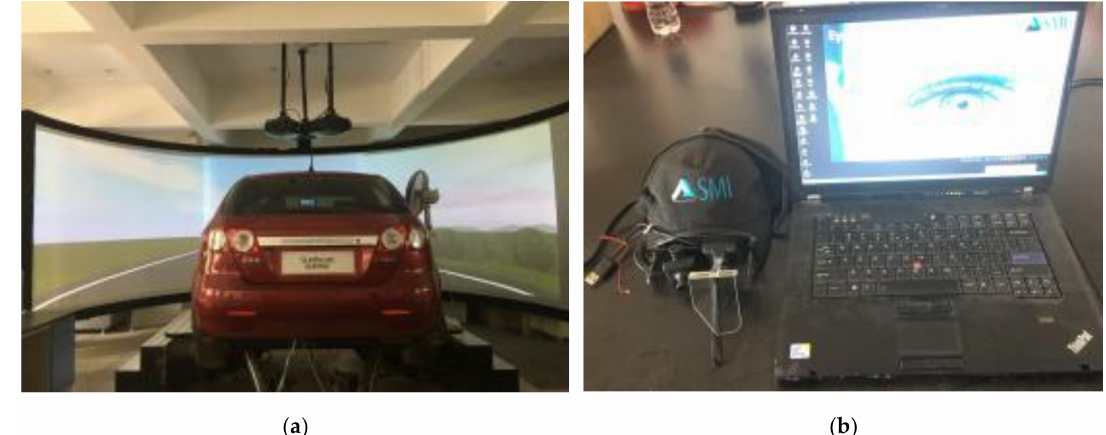
Figure 1. Apparatus of study. ( a ) The driving simulator; ( b ) the eye tracker.